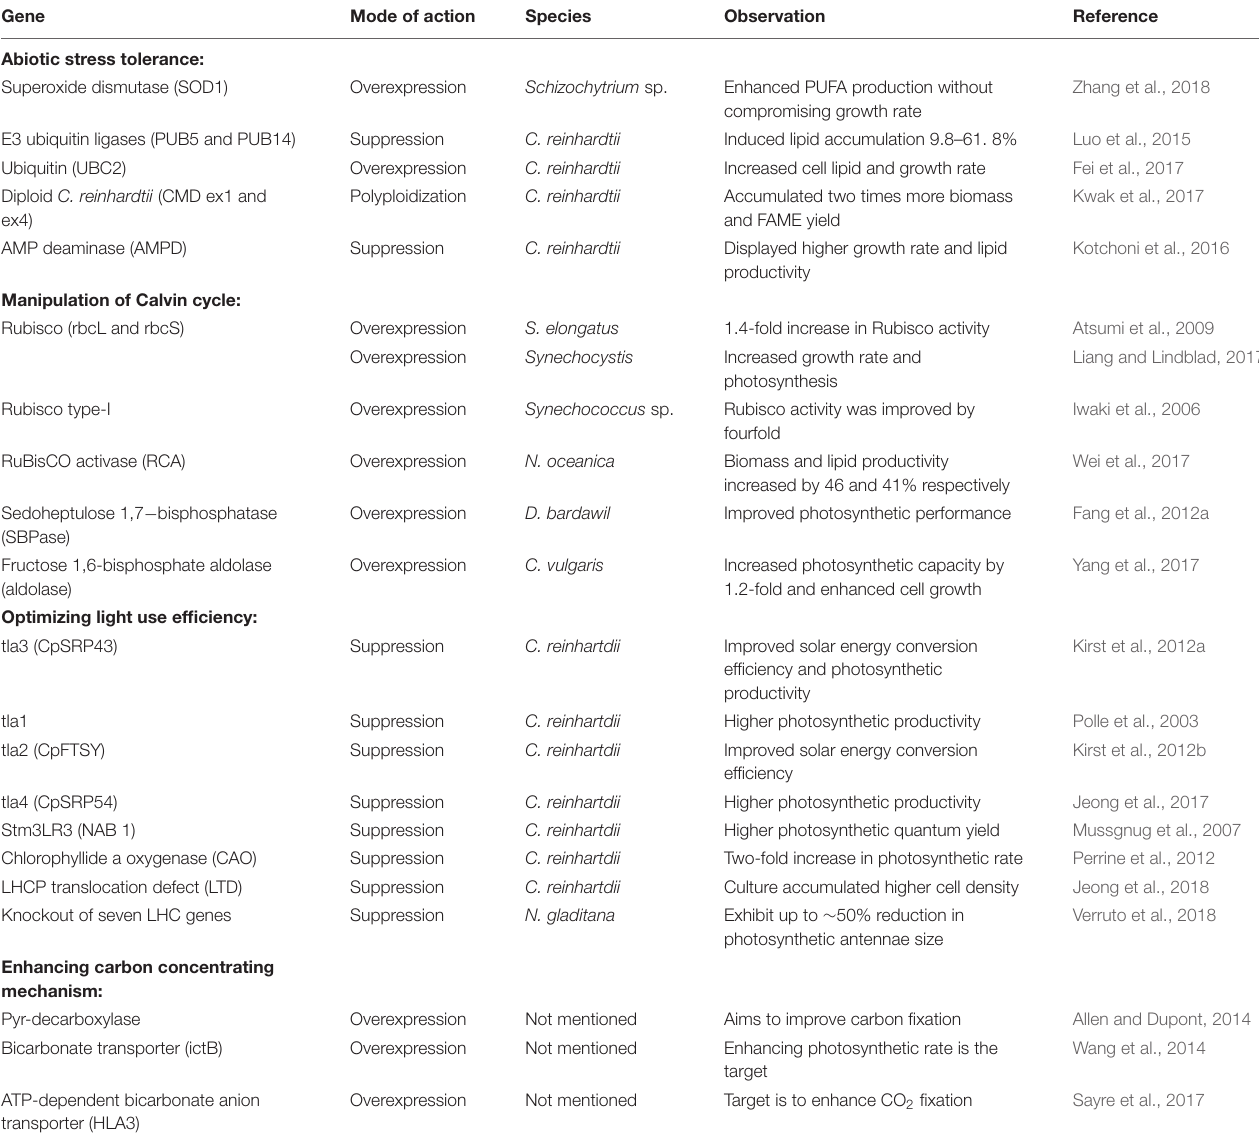
TABLE 2 | Summary of genes manipulated for increasing the biomass